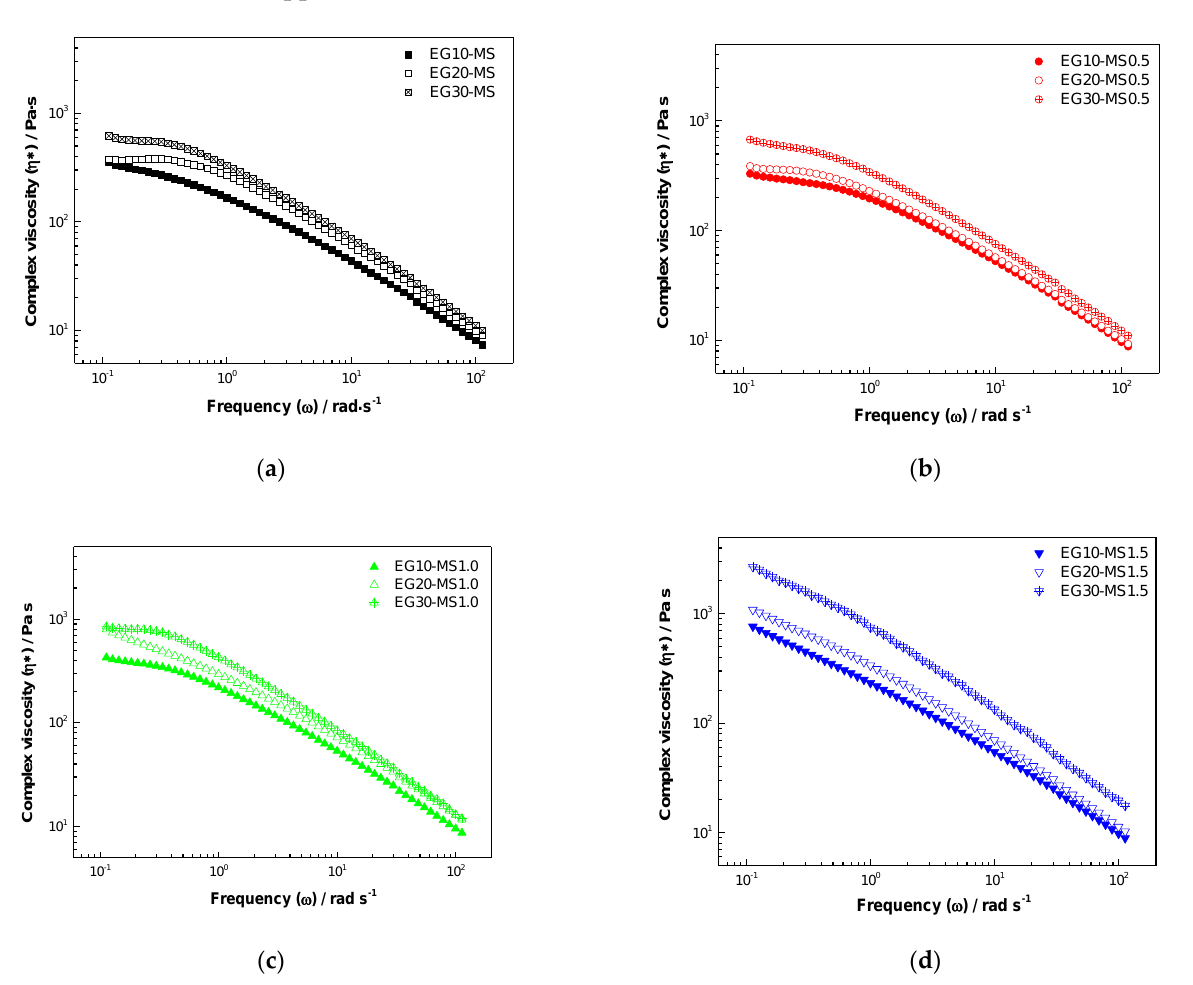
Figure A1. Complex viscosity of carboxymethyl cellulose/mango-starch emulsion gels with 1% w/w of mango peel extracts at ( a ) 0%, ( b ) 0.5%, ( c ) 1.0% and ( d ) 1.5% of starch.